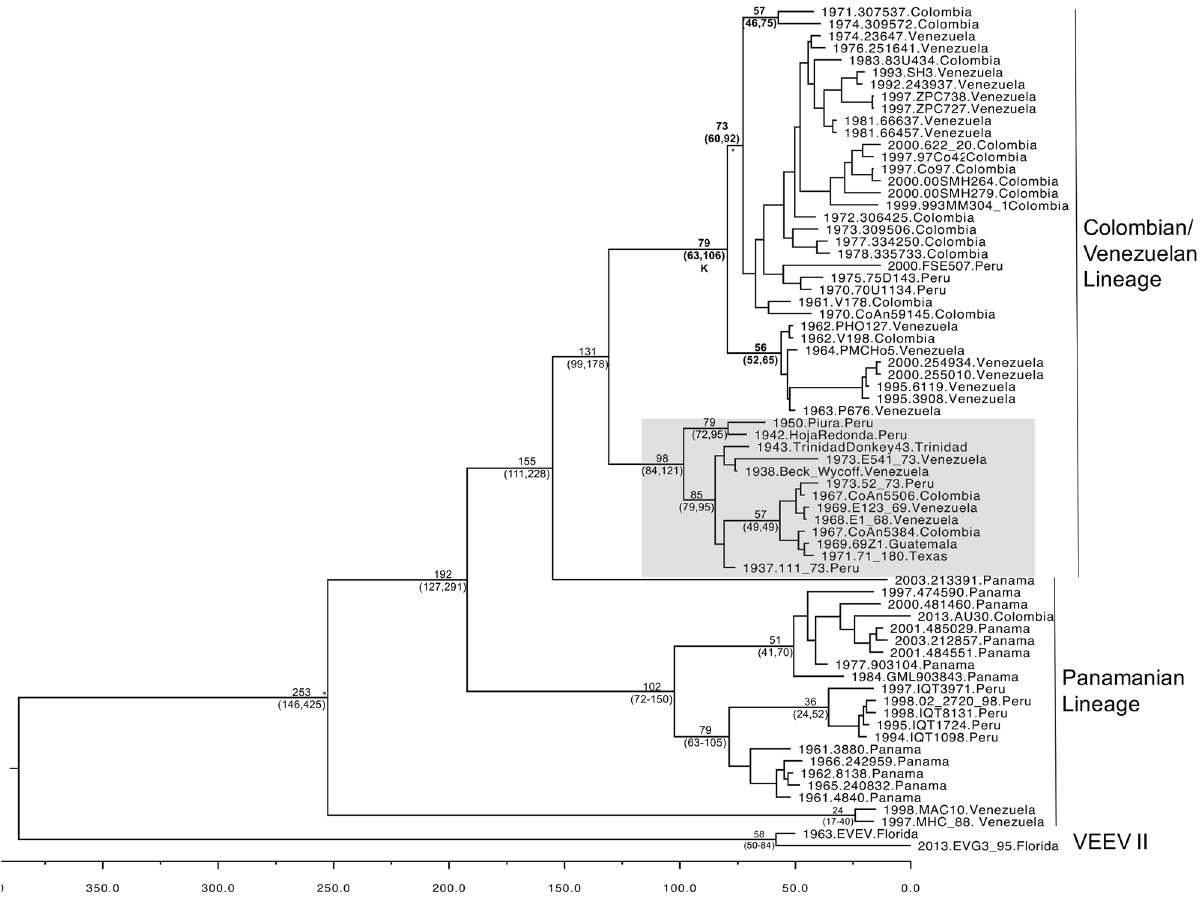
Fig 3. The genetic relationships of the II/ID/IAB/IC subtypes of the VEEV complex. MCC tree as determinedby coalescentanalysisfor the ID/II strains with the IAB and IC strains included.All branches had posterior probabilities of > 0.97 except for the branchesmarked with a * , which did not have significantsupport. The time to most recent common ancestors (tMRCA) dates for individualbranches as identified from the MCC tree are indicatedon significantbranches with the highestposterior density (HPD) in brackets, dates of clades supported by BSREL were emboldened.Subtype IAB strains are highlightedby the grey